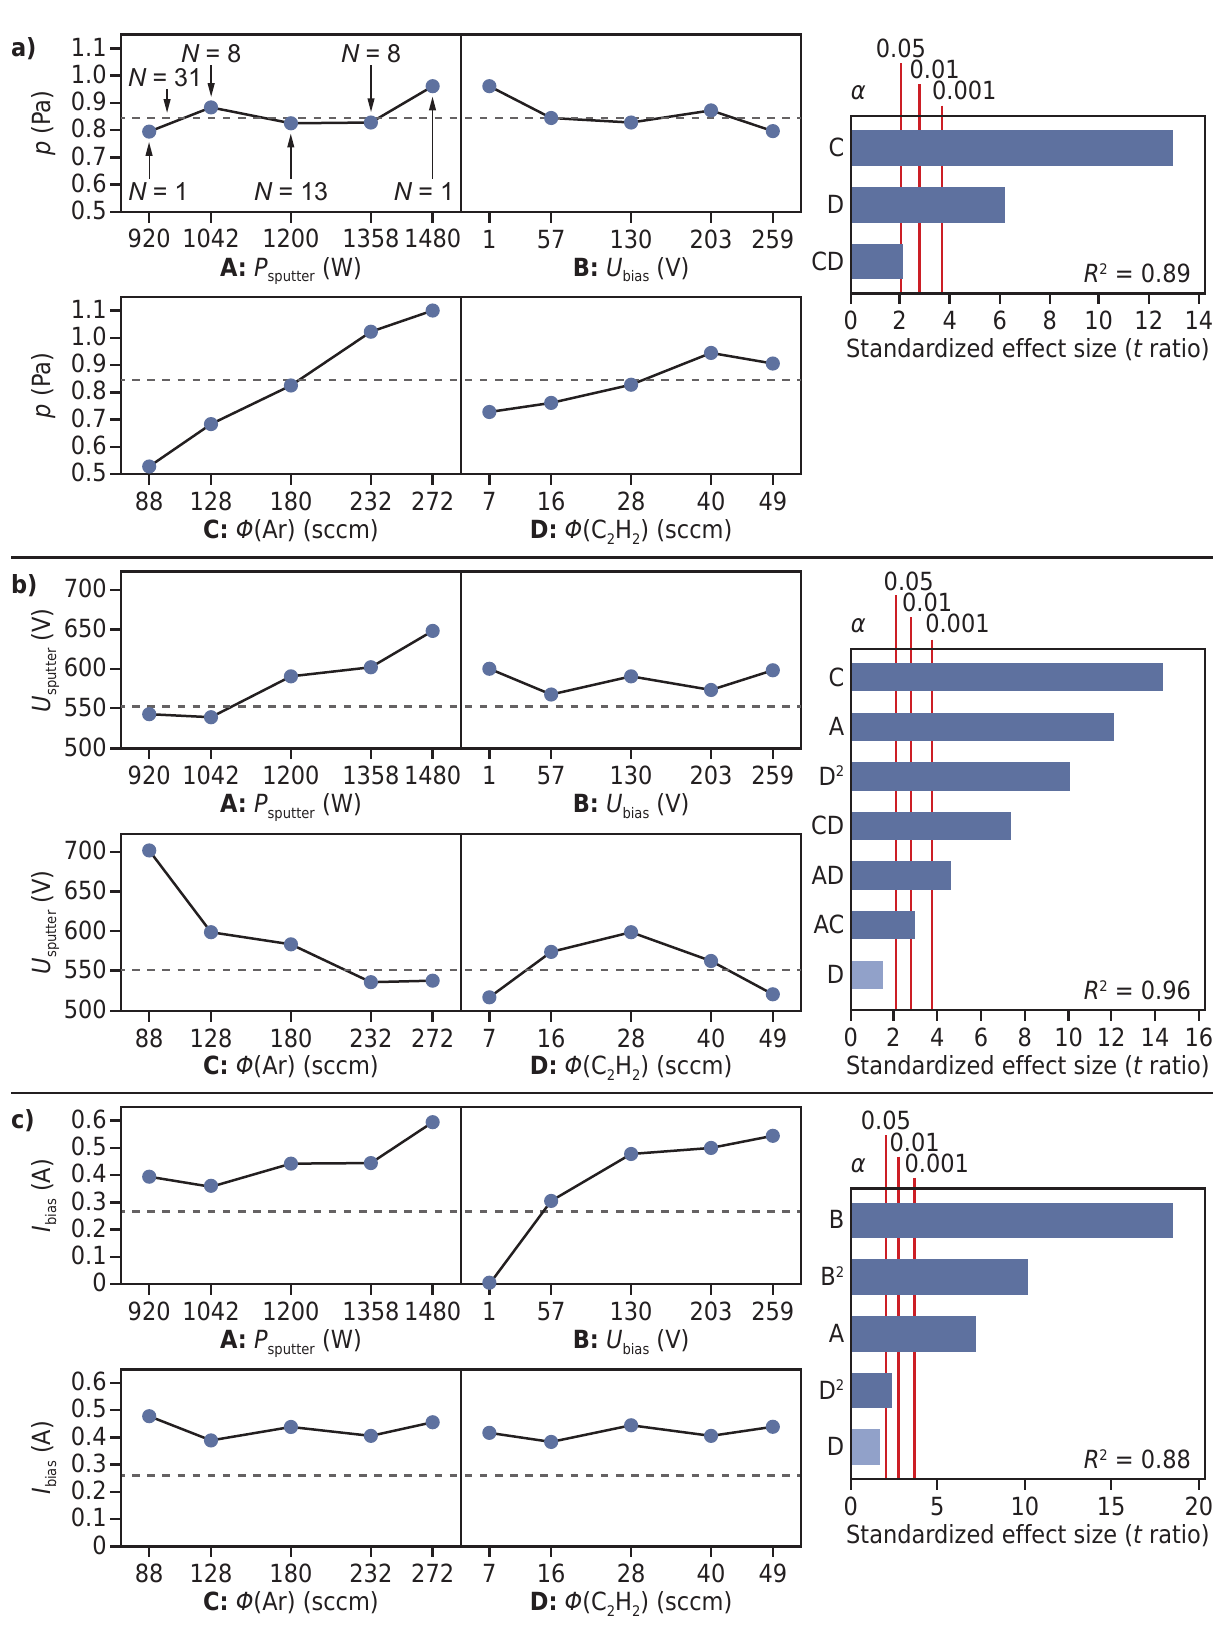
Figure 5. Main effect plots and Pareto charts of standardized effects showing the relationship between the varied deposition parameters and the measured process variables: Total pressure ( a ), sputtering voltage ( b ) and bias current ( c